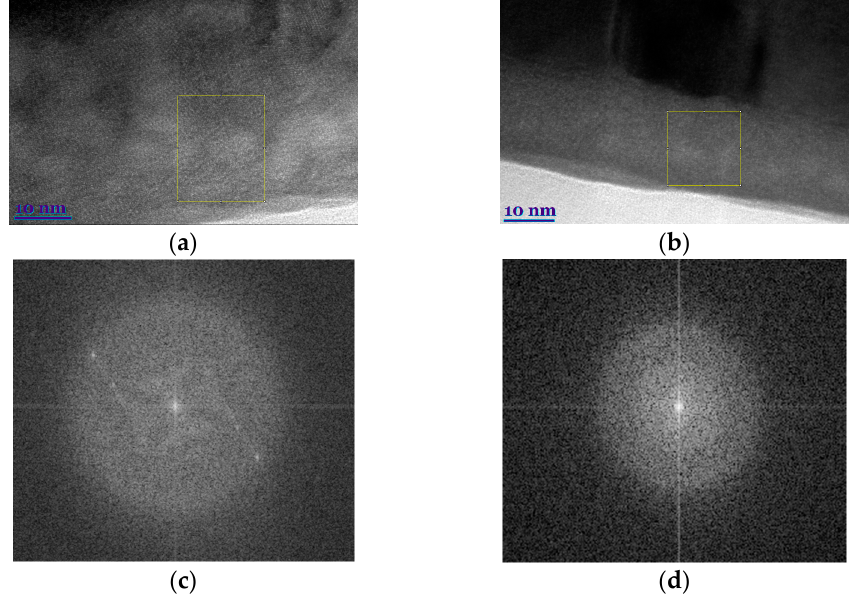
Figure 3. HR TEM image of an interface between the LSMO film and substrate: quartz ( a ) and Si/SiO 2 ( b ). Fast Fourier transformation (FFT) patterns of the marked square area ( c , d ), respectively.